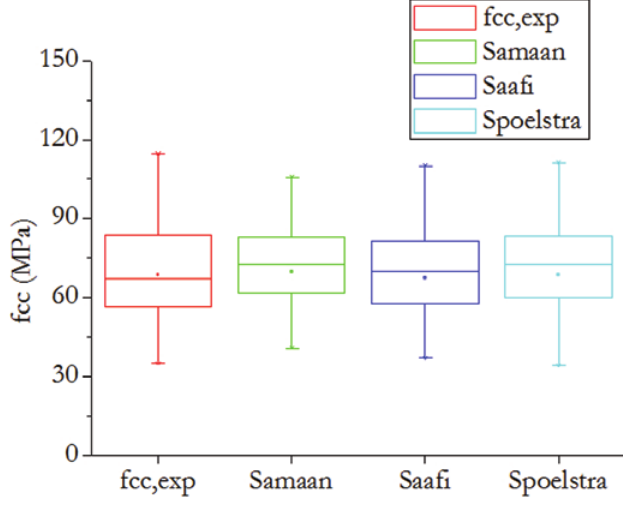
Comparação teórico-experimental da resistência à compressão do concreto confinado (f de confinamento com PRF. (a) Método de Samaan; (b) Método de Saafi; (c) Método de Spoelstra. CC: Coeficiente de correlação; DP: Desvio